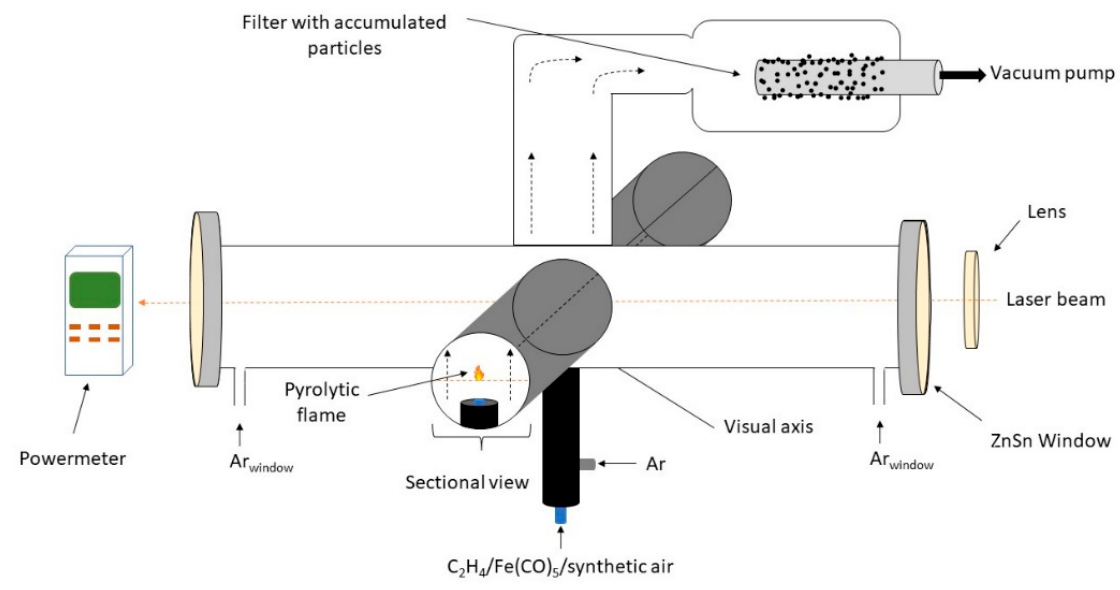
Figure 1. Laser pyrolysis of iron oxide nanoparticles.